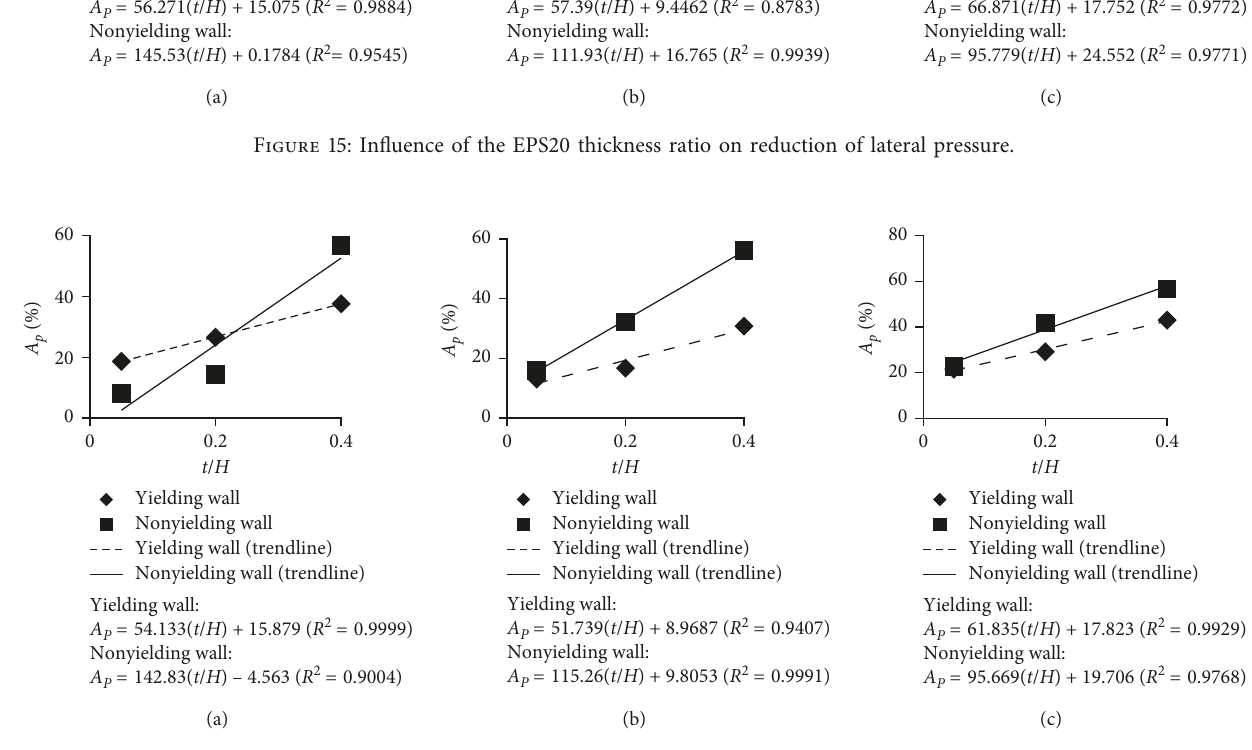
Figure 16: Influence of the EPS25 thickness ratio on reduction of lateral pressure.